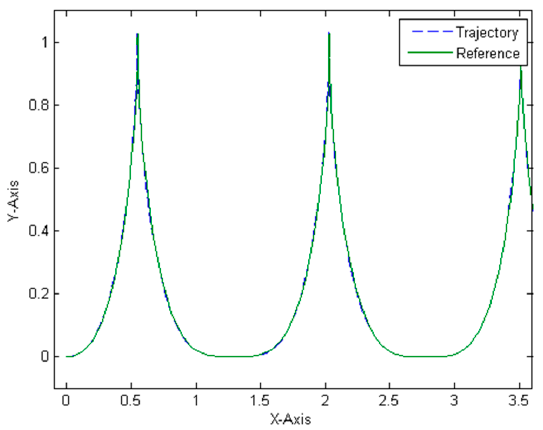
Figure 16. Best simulation of the PSO algorithm.